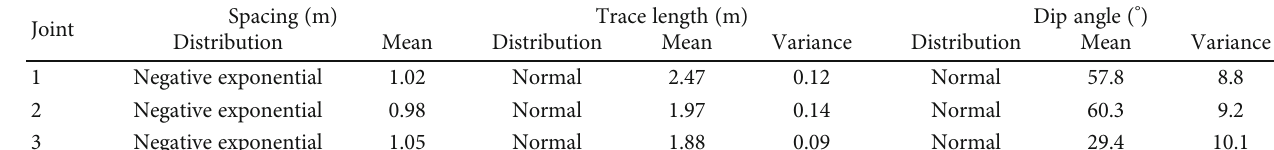
Table 1: Distribution statistics of joint geometric parameters.